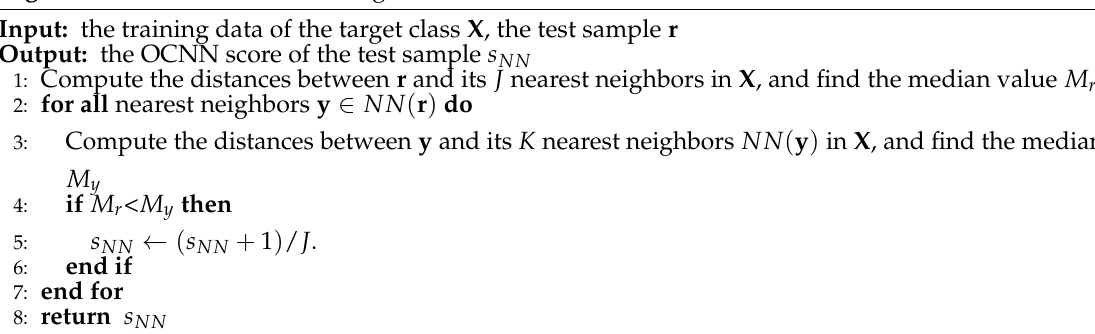
Algorithm 1 One-class nearest neighbor